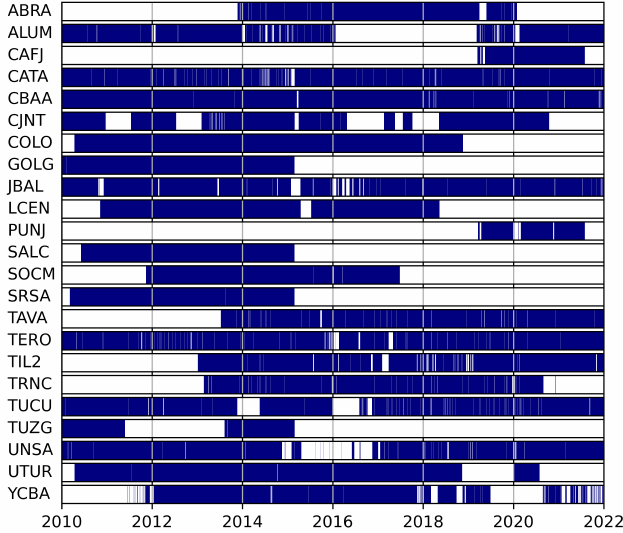
Figure 2. Temporal coverage of the stations used in this study. Blue areas indicate times with data